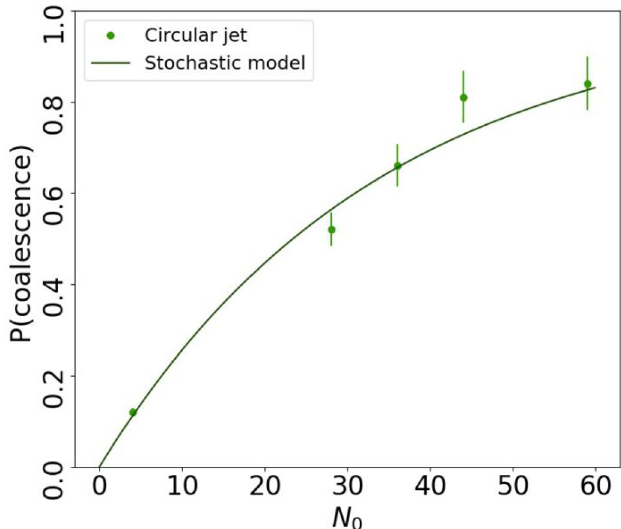
Fig. 11. Experimental proportion of bubbles coalescing as a function of N 0 and theoretical value from the equation